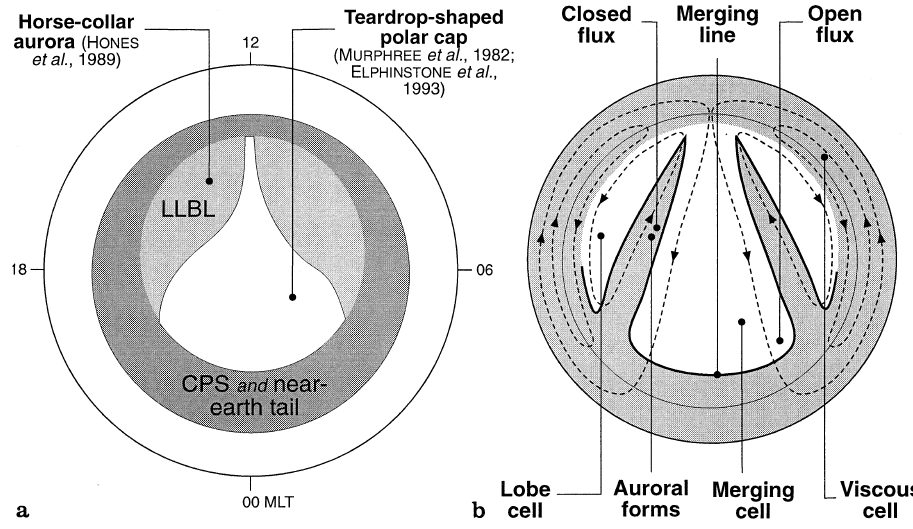
Fig. 8. a The horse-collar auroral configuration (Hones et al ., 1989) and teardrop-shaped polar cap (Elphinstone et al ., 1993) proposed for northward IMF conditions; b Convection flow (Burch et al ., 1992) and open and closed field regions (Henderson et al ., 1996) proposed for northward IMF con- ditions. The tongues of closed flux extending across the ‘‘polar cap’’ are associated with convection re- versals and hence polar